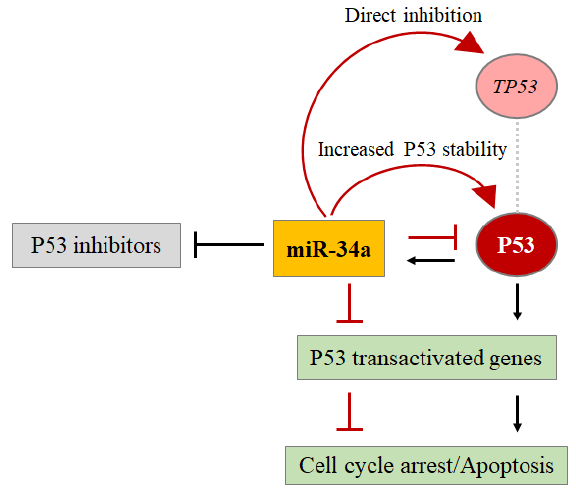
Figure 7. The recurrent autoregulatory circuit between miR-34a and P53. P53 regulates the expression of miR-34a which regulates P53.